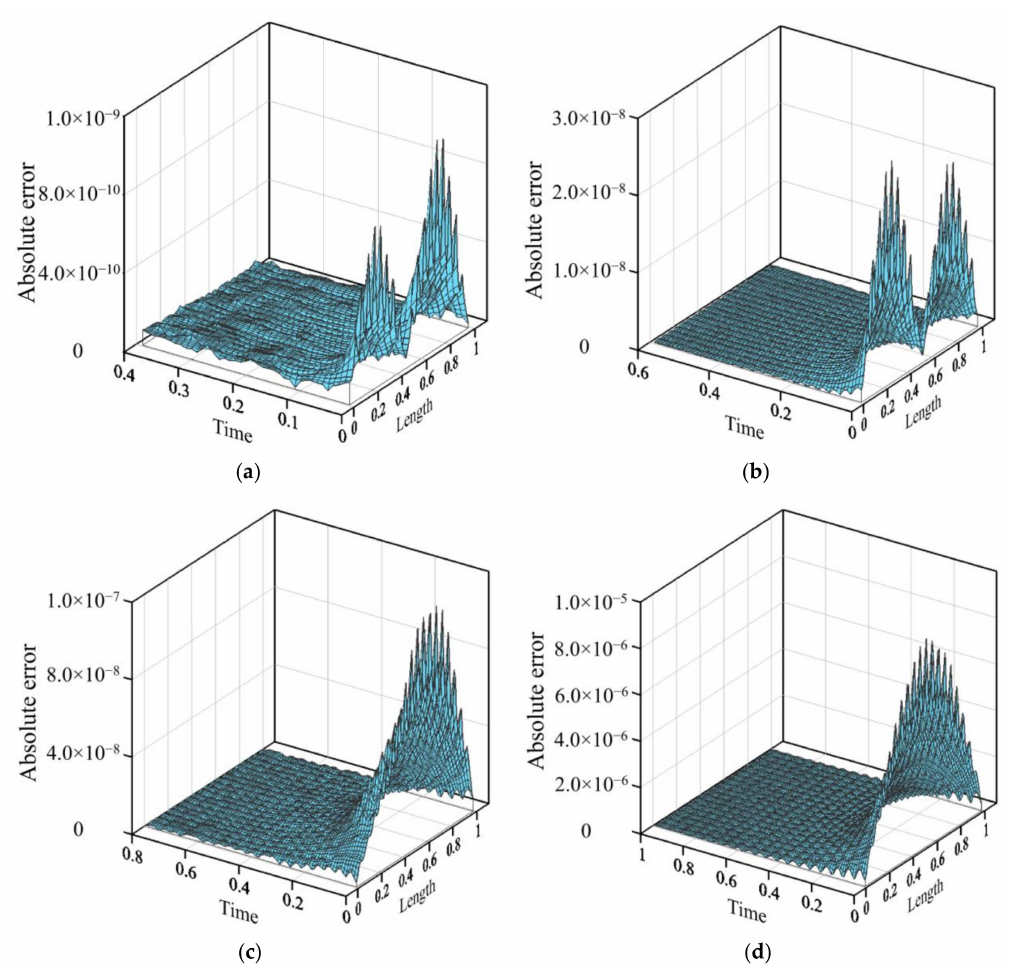
Figure 11. The absolute error of the proposed method with the consideration of di ff erent final elapsed time: ( a ) T = 0.4; ( b ) T = 0.6; ( c ) T = 0.8; ( d ) T =